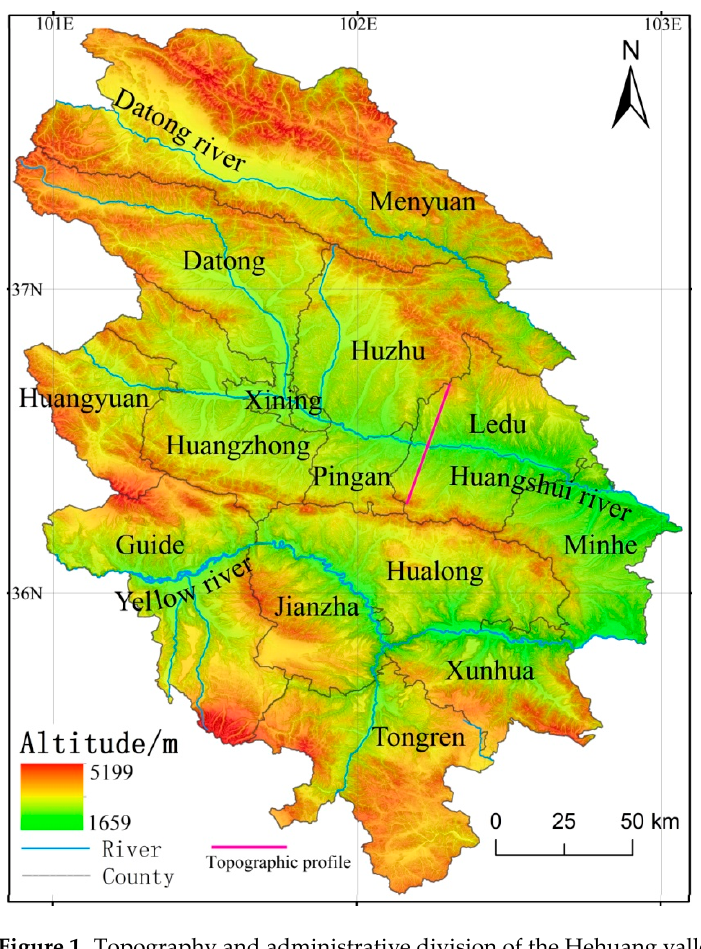
Figure 1. Topography and administrative division of the Hehuang valley.